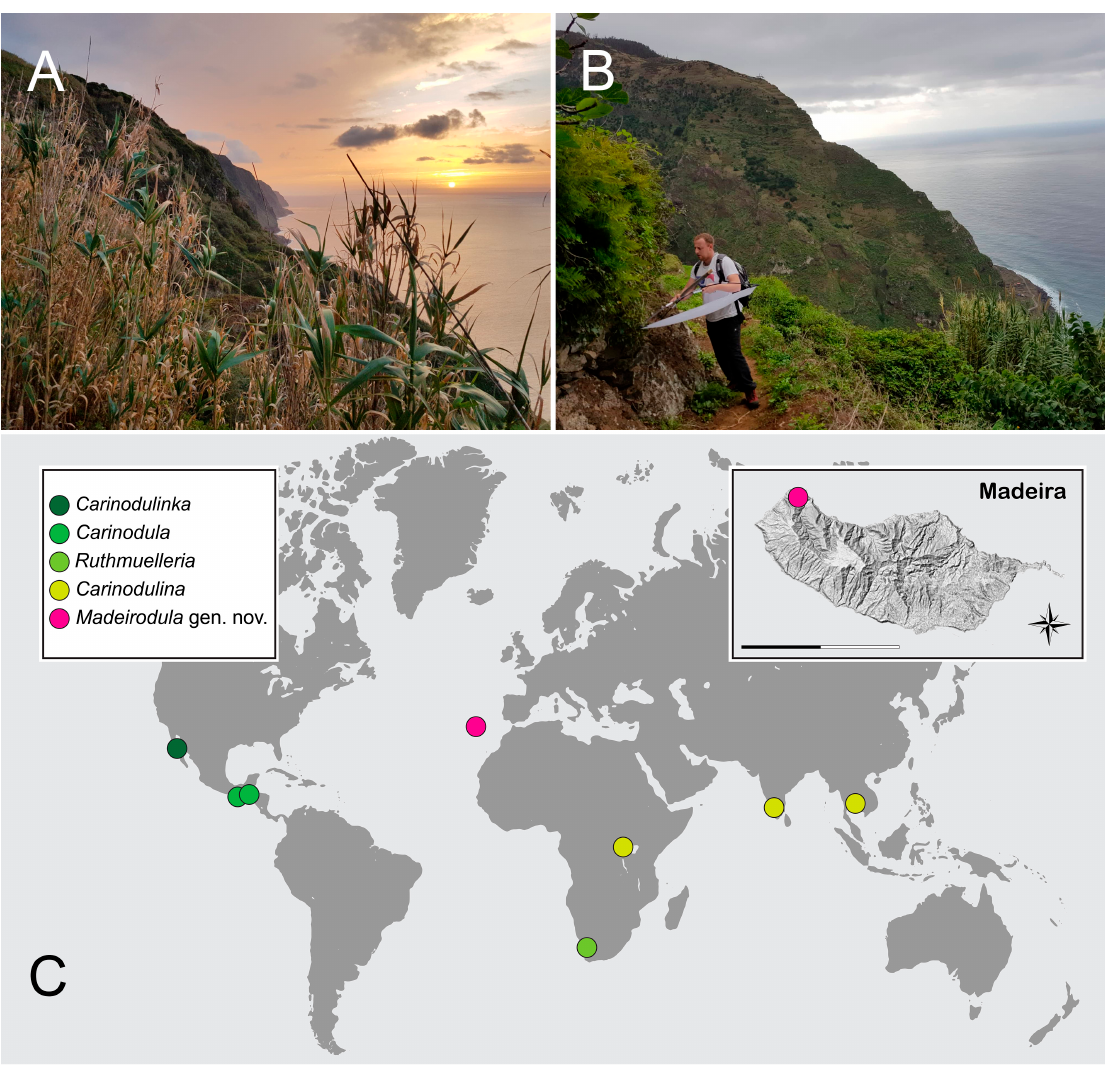
Figure 5. ( A , B ) Type locality and habitat where type specimens were captured. ( C ) geographic distribution of Carinodulini and Madeirodulini taxa, with indication of the type locality on Madeira Island. Scale bar: 30